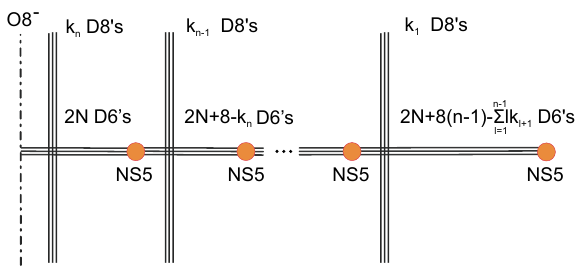
Figure 22 . Type IIA brane con(cid:12)guration for the 6d linear quiver theory (4.2).